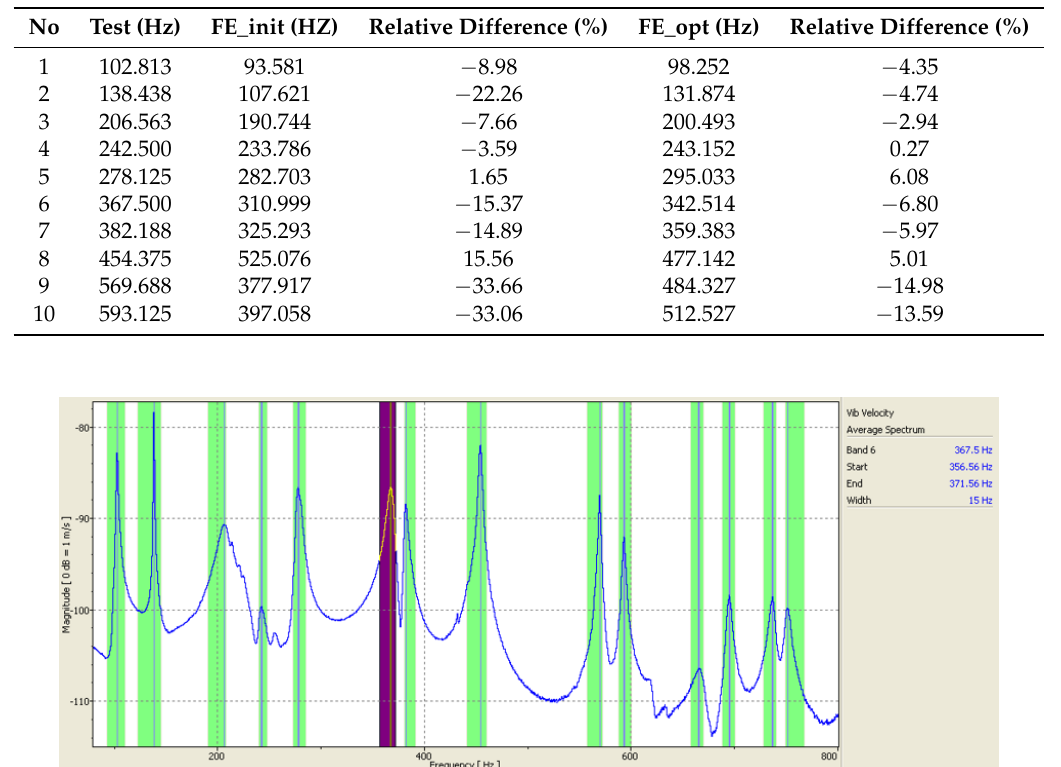
Figure 7. Frequency response function of the expermimental LDV